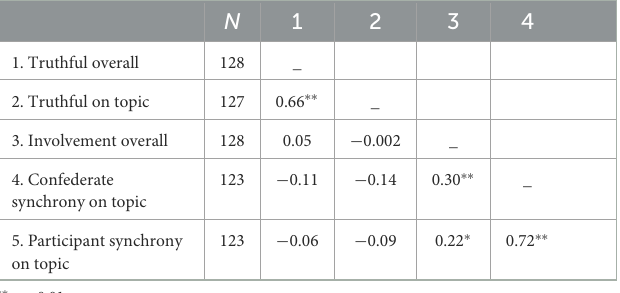
TABLE 1 Correlations of all dependent